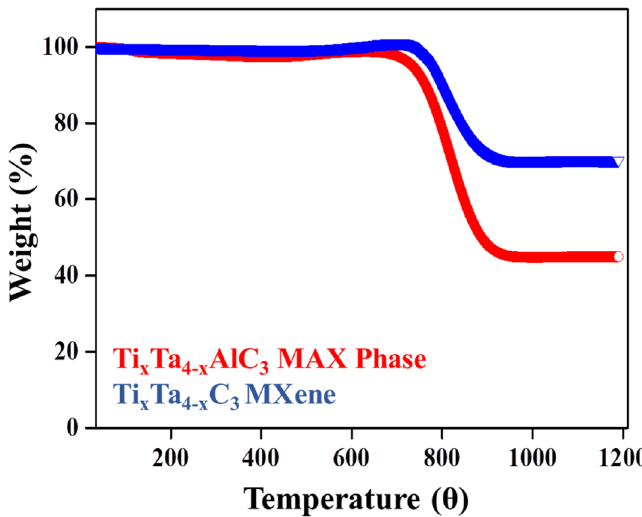
Figure 7. TGA behavior of the bi-metallic Ti x Ta (4−x) AlC 3 MAX phase (Red) and Ti x Ta (4−x) C 3 MXene (blue).